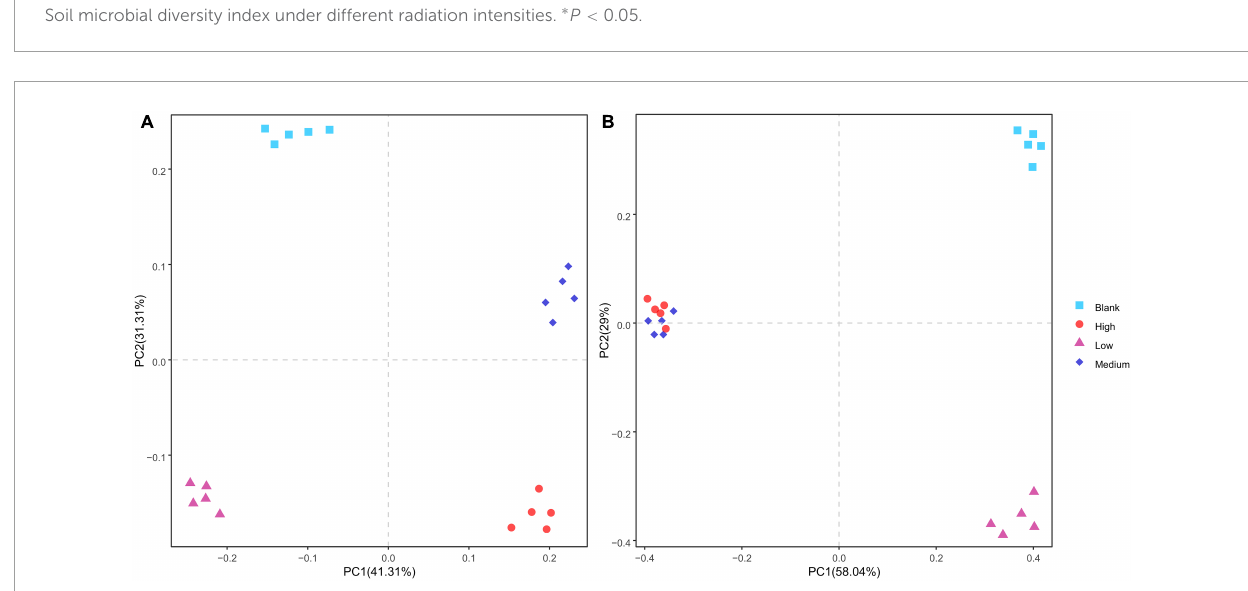
FIGURE4 Principal components analysis of the β diversity of panel (A) bacteria and (B) fungi under different radiation